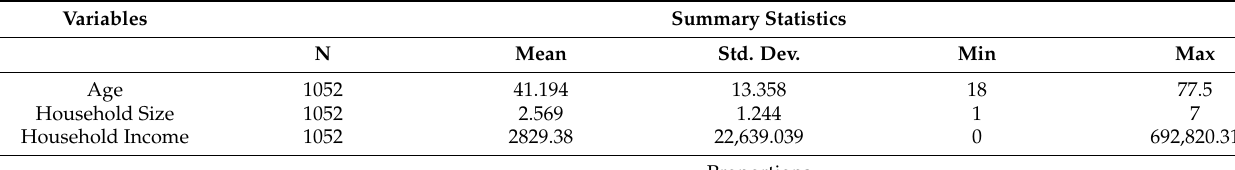
Table A4. Descriptive statistics of socio-demographic